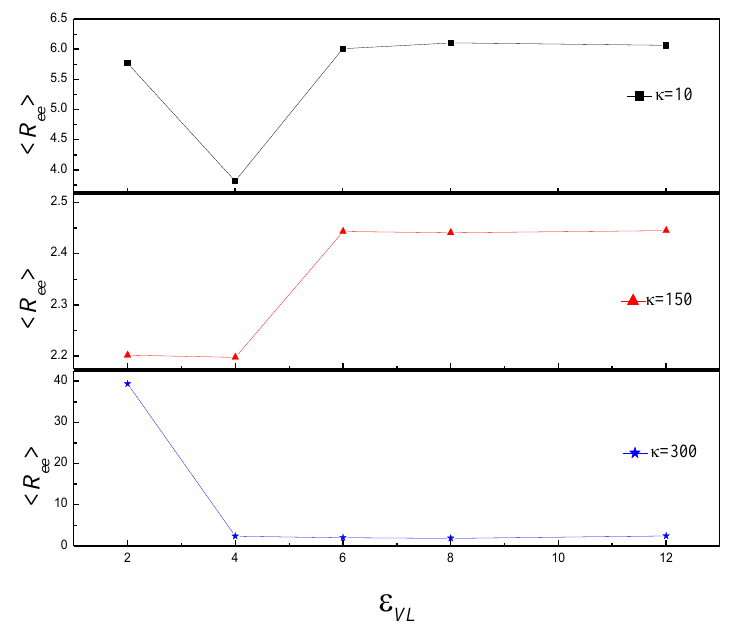
Figure 7. The mean end-to-end distance < R ee > versus ε VP for κ = 10, 150, and 300. Next, the vesicle shape is studied by the tangent–tangent correlation < b k · b k+s >. Figure 8a shows that < b k · b k+s > of ε VP = 4 has three troughs, while < b k · b k+s > of other ε has two troughs for κ = 10. It indicates that the vesicle forms triple vesicle for ε VP = 4, while it forms double vesicle for other ε VP . The results of Figure 8b indicates that vesicle shape of ε VP = 2, 4 and 6 is circular, the vesicle shape of ε VP = 8 is cigar-like, the vesicle shape of ε VP = 12 is bent-cigar-like for κ = 150. The results of Figure 8c indicate that the vesicle shape firstly shifts from a random shape to a circular shape, then shifts to a racquet-like shape with ε VP increase for κ = 300.